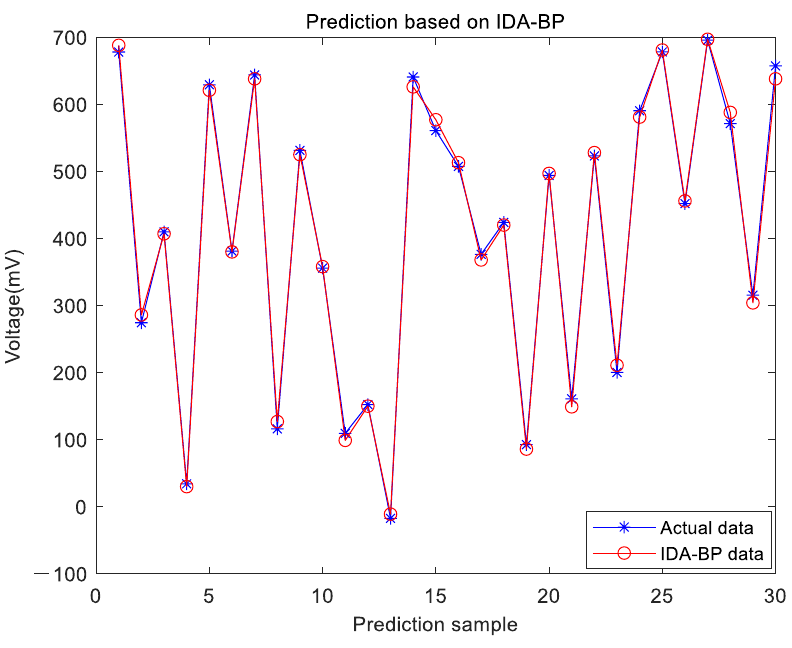
Figure 7. Prediction based on IDA-BP.